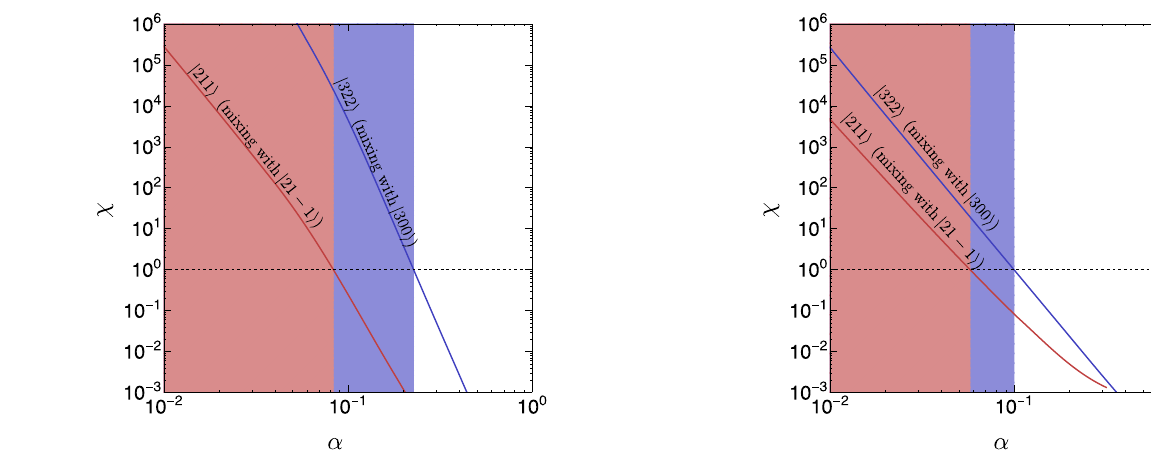
Fig. 6 | Evaluation of the stability of the superradiant cloud in the presence of an accretion disk. Colored lines: perturbation estimator χ , de fi ned in Eq. (11), for the mixings between different superradiant and decaying levels induced by a thin accretion disk with an m pert =2 harmonic perturbation in its density pro fi le, as speci fi ed by Eq. (13). Red and blue lines show the mixing of the ∣ 211 i and ∣ 322 i clouds with selected decaying levels. Colored regions: values of the gravitational parameter α for which the perturbation estimator χ >1 for the aforementioned transitions, in which case the corresponding clouds are unstable against the disk perturbations.